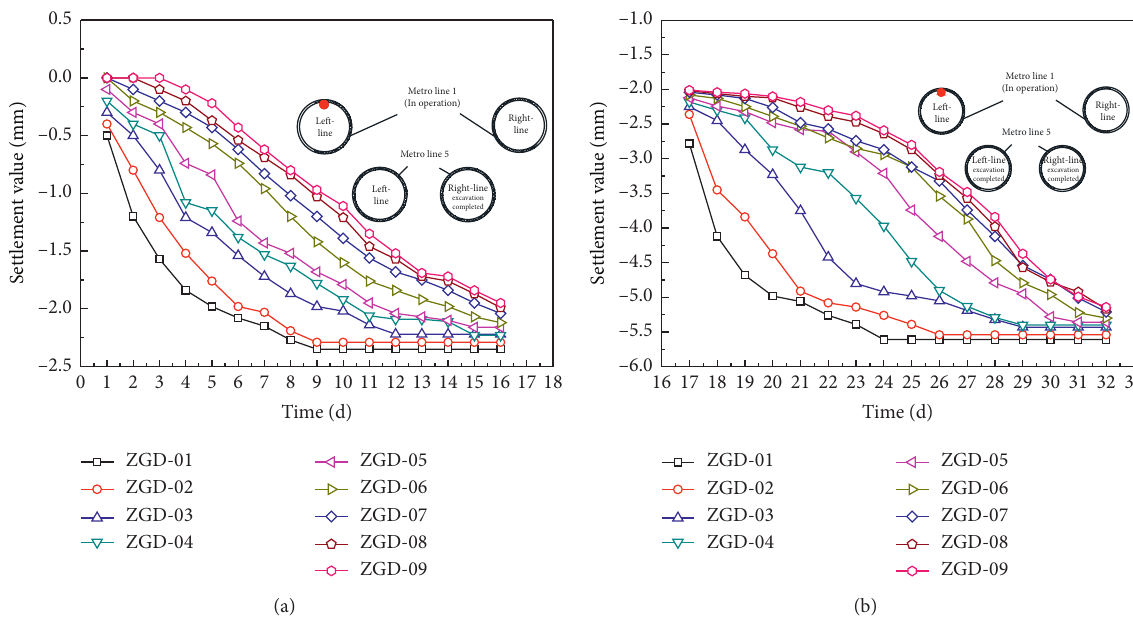
Figure 3: Time history curve of tunnel arch crown settlement of left line of line 1 caused by excavation construction of line 5 (field- monitoring results). (a) Right-line tunnelling. (b) Left-line tunnelling.